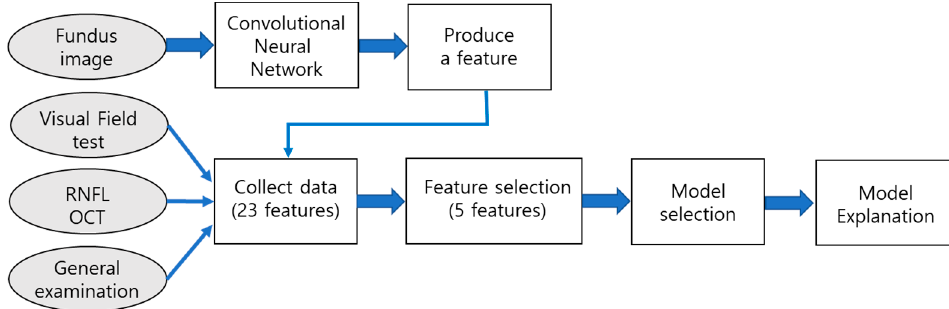
Figure 1. Procedure of prediction model development. Table 2. List of candidate features for Model building.